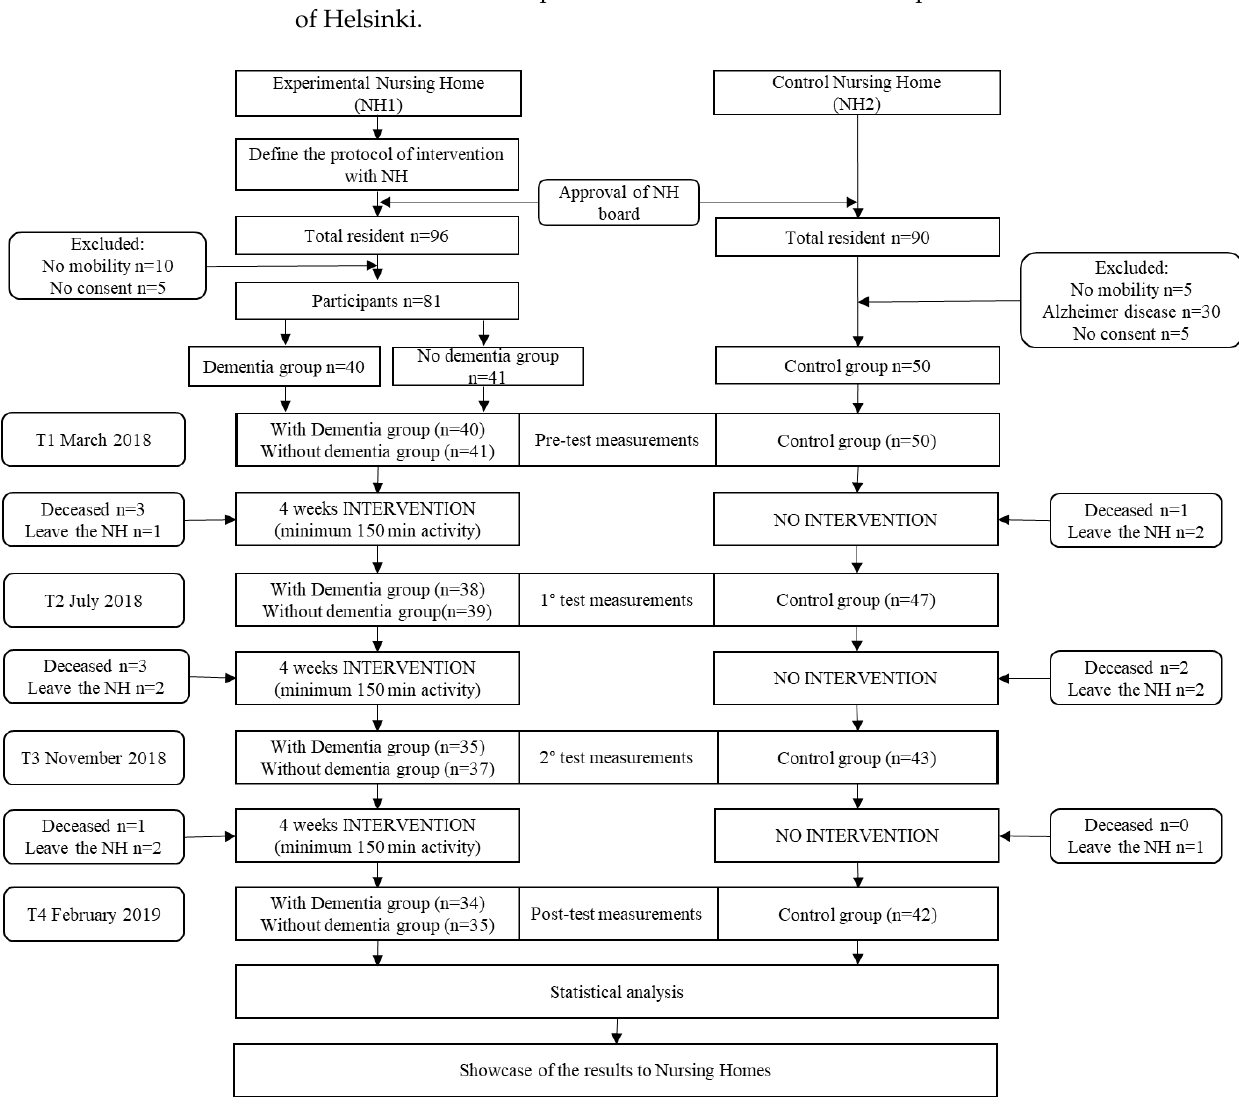
Figure 1. Recruitment process and attendance information of the study